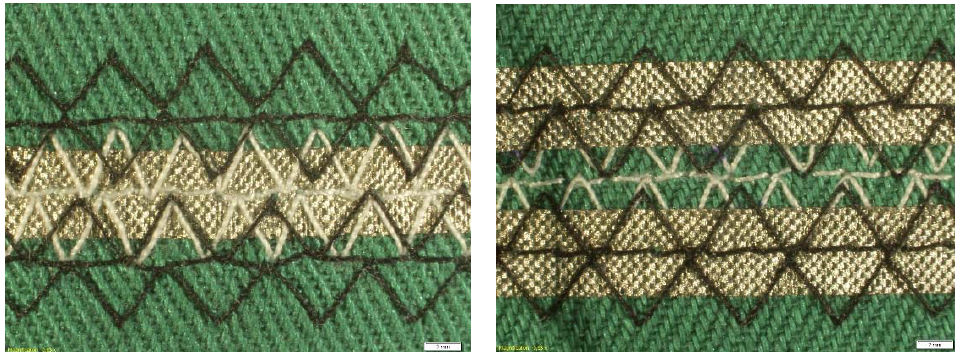
Figure 2. Examples of the view from the top (on the left) and the bottom (on the right) of the con ‐ structed line (white scale bar = 2 mm).